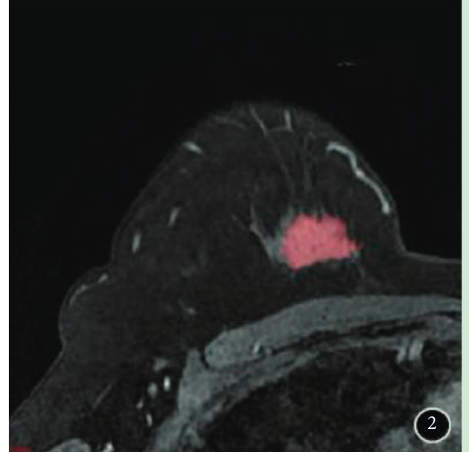
Figure 2: Morphological features of phase 3 DCE-MRI in early recurrence